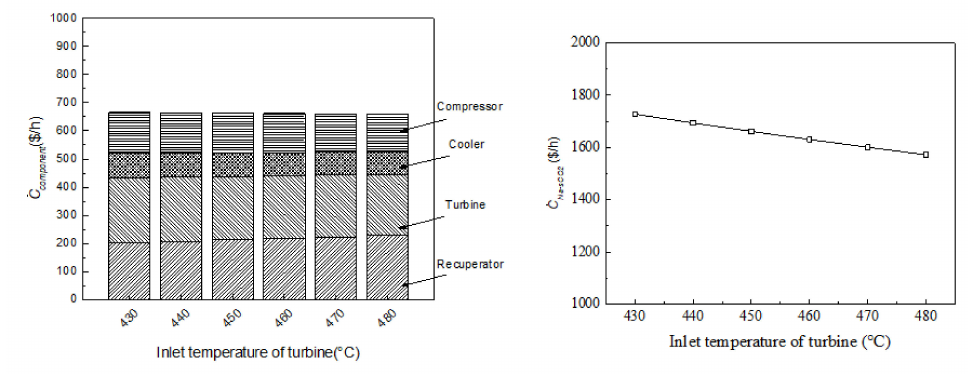
Figure 17. Effects of T max on